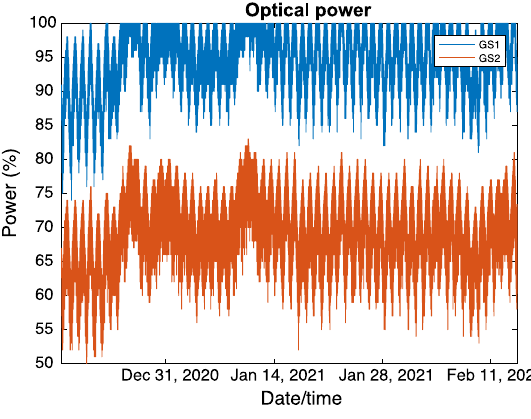
Fig. 11 Optical power received by both gas monitoring stations. When expressed in percentage, we have for GS1 96.8% ± 3.9% and 72.1% ± 4.9% for